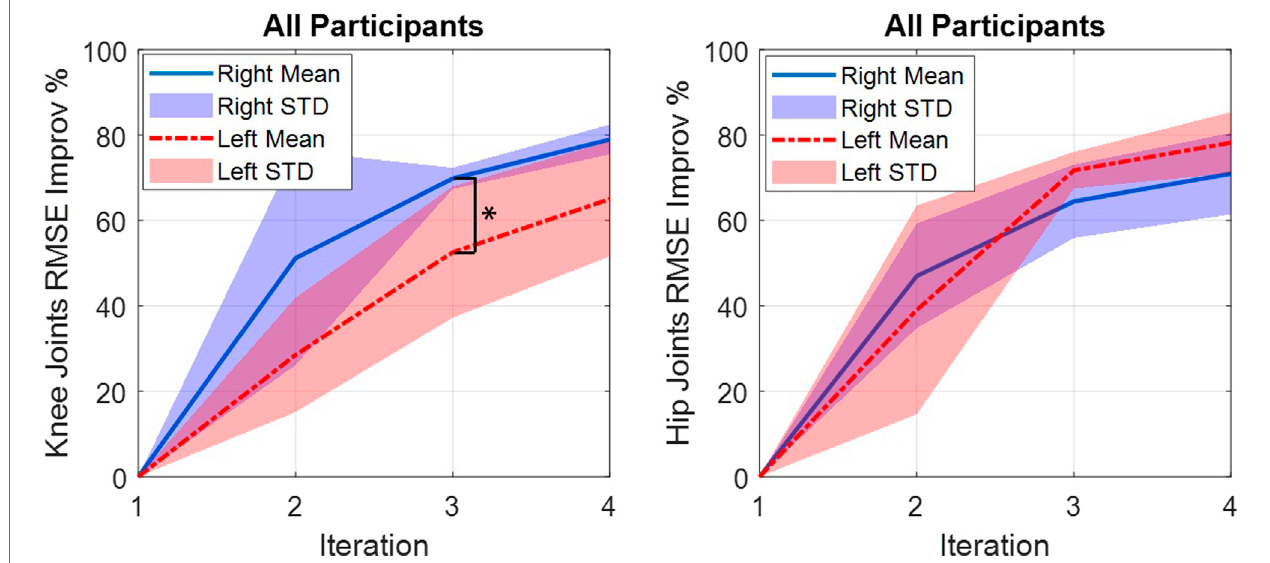
FIGURE 8 | Improvements in the mean RMSE for all participants. Solid and dashed lines show the mean, and the shaded areas show the standard deviation.